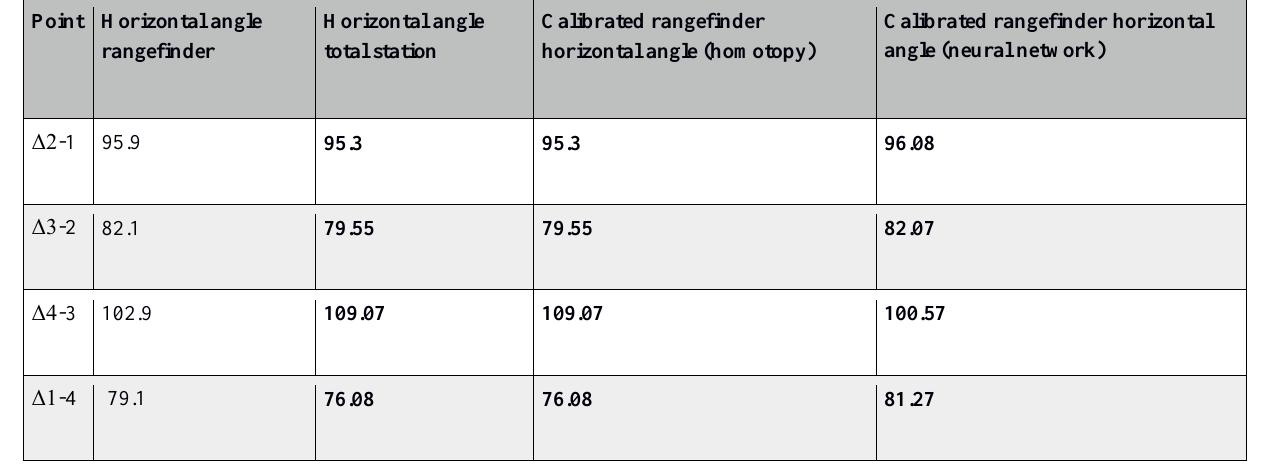
Figure 14: The gradient, µ values and validation checks. Geometrical information using neural network and homotopy continuation for room 10 is presented in Table 7. Table 7: Calibration of room 10 rangefinder horizontal angle measurements using total station horizontal angle measurements by homotopies and neural network (in decimal